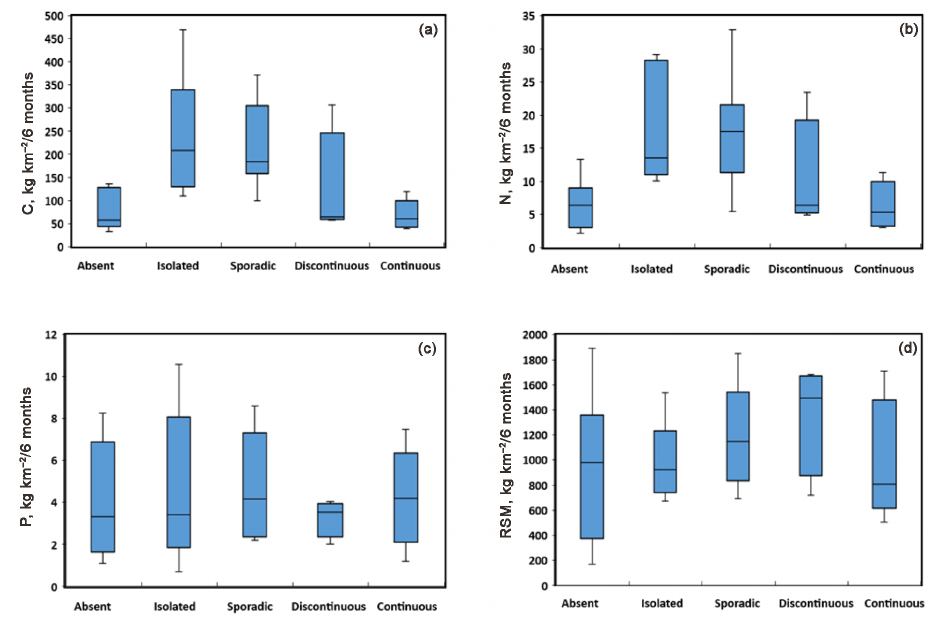
Figure 6. Total open-water-season (May to October) fluxes of particulate C (a) , N (b) and P (c) , and suspended matter (d) in five permafrost- free and four distinct permafrost zones of WSL (box plots of first and third quartiles). There is a clear maximum of C and N export at the beginning of permafrost appearance, in the isolated-to-sporadic permafrost